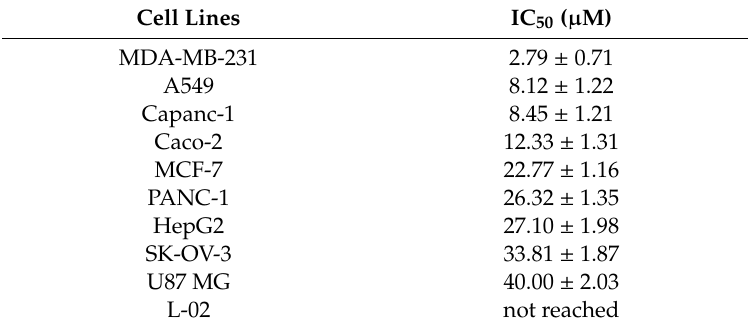
Table 1. IC 50 of TSC-3C in a variety of cell lines. The data are expressed as the